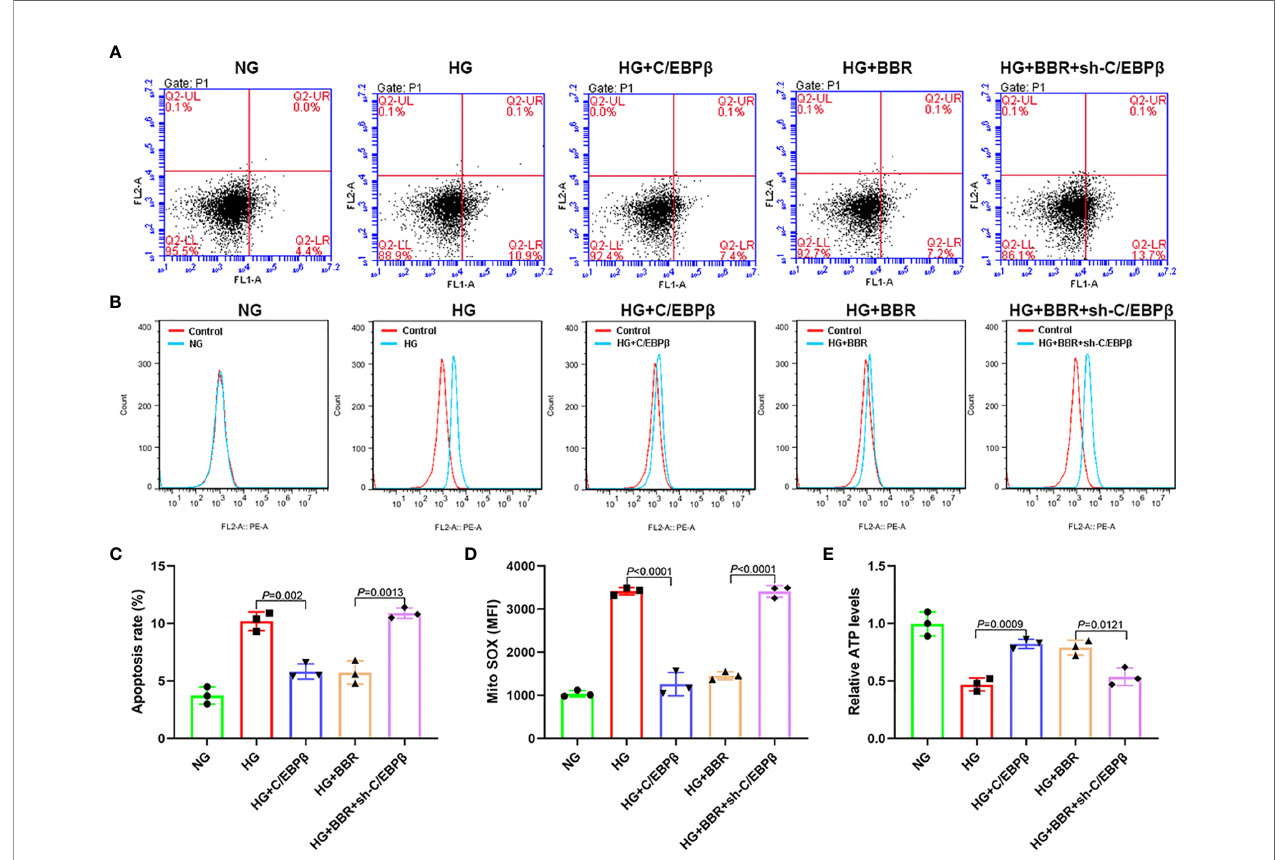
FIGURE 5 | BBR relies on C/EBP b to regulate mitochondrial ROS levels of HK-2 cells in high glucose environment. (A, C) The apoptosis ratio in different groups. (B, D) Mitochondrial ROS in different groups. (E) Relative ATP content in HK-2 cells of different